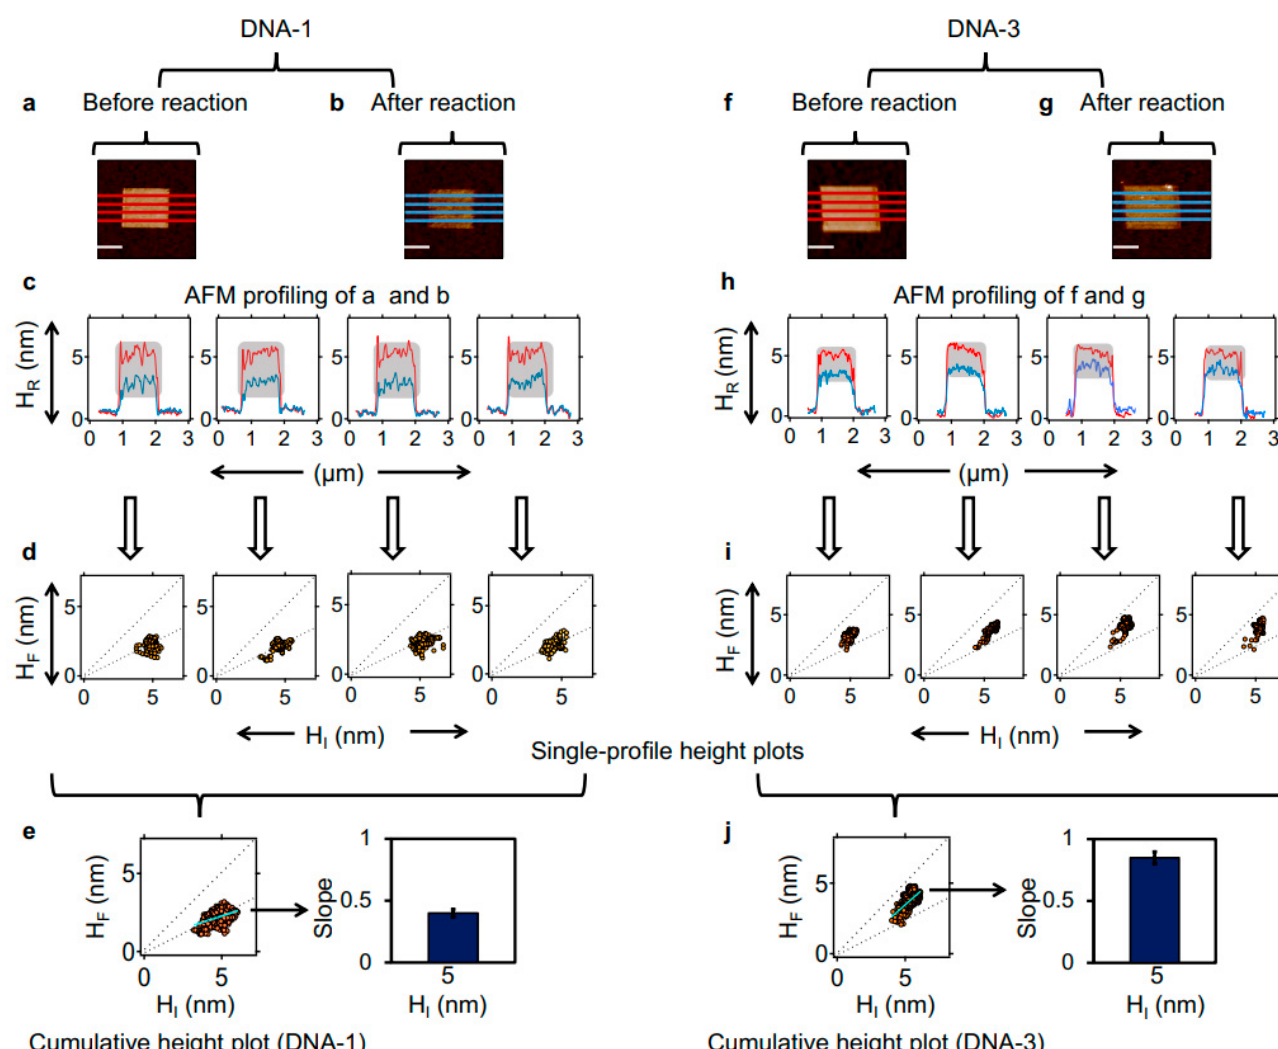
Figure 4. Quantitative differential analysis of BamHI action reveals LCDM density heterogeneity. AFM micrograph of a DNA-1 (cognate) and DNA-3 (non-cognate) LCDM before (( a , f ), respectively) and after BamHI action (( b , g ), respectively). ( c , h ): four side-by-side AFM height profiles are ex- tracted from ( a , b , f , g ), respectively. Each pair of AFM profiles (before and after reaction, respec- tively) correspond to the same nanostructure positions. The H I (red) and H F (blue) data points, ex- clusively related to the surface-bound DNA in ( c , h ) (see grey squares), are filtered and graphed in ( d , j ), respectively. The dashed lines are guides corresponding to an H F /H I ratio of 100% and 50%, respectively. ( e , j ) (left) Data are pooled from ( d , i ), respectively; (right) the average slope of the linear fit on the left for LCDMs. In ( a , b , f , g ), the scale bar is 750 nm and the inter-line separation along the slow-scan direction is 200 nm. Encouraged by the high-resolution analysis above, we extended the approach to study BamHI’s behaviour over a broad density range, using both direct and negatively nanografted LCDMs. The results are shown in Figures 5 and 6. In cognate (DNA-1) LCDMs, BamHI action is complete for H I < 14 nm (see Figure 5a), which is a threshold likely reflecting a surface DNA density above which DNA cleavage site accessibility is inhibited by steric hindrance [13]. Surprisingly, noncanonical DNA cleavage by BamHI varies for non-cognate sequences (DNA-2 and DNA-3). In both cases, and in agreement with the qualitative analysis in Figure 3n,u, the DNA cleavage efficiency is an apparent step function of the DNA density, as reflected by the initial height, and presents three